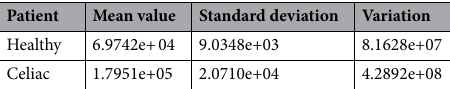
Table 8. Interpretation of the values obtained after applying the Sobel